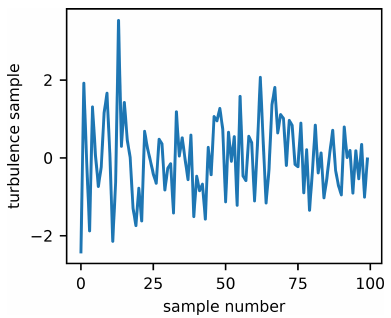
Figure 2. The set of turbulence samples, S , used in this study. Turbulence intensity is defined as TI = σ u /u , where σ u is the stan- dard deviation in wind speeds over a given time, and u is the mean wind speed. These turbulence samples are used in a future step to calculate an instantaneous wind speed adjusted for turbulence as u i = U steady (1 + S i